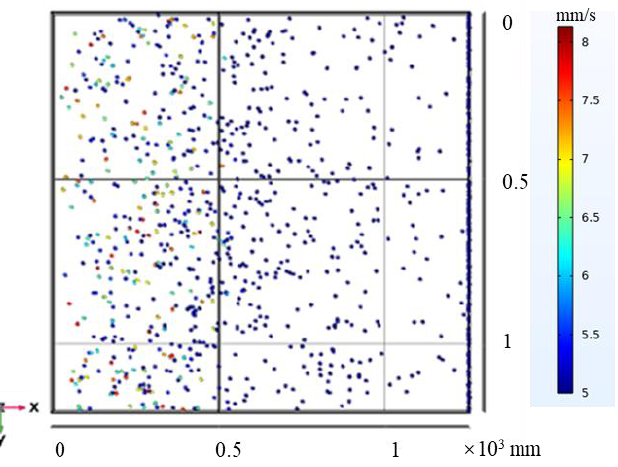
Figure 9. Particles embedded in the adhesive layer in the mechanical model ( z = 100 mm).